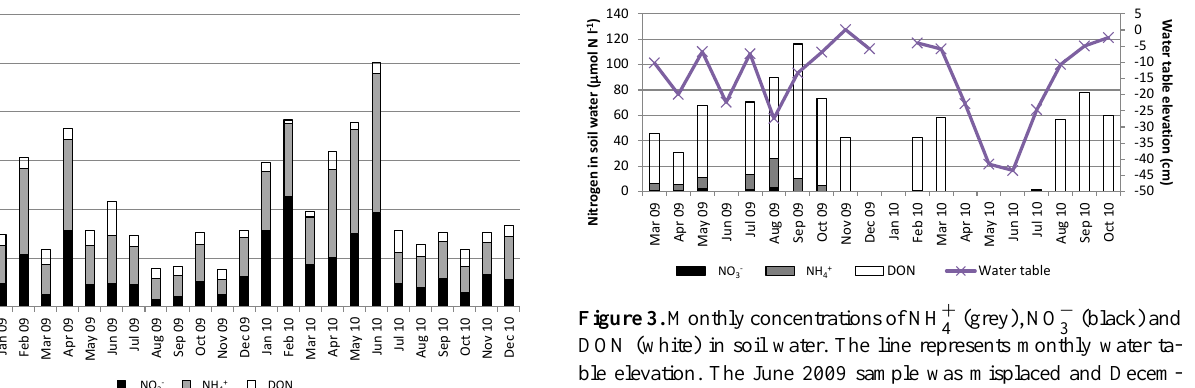
(grey), NO − (black) and 4 3